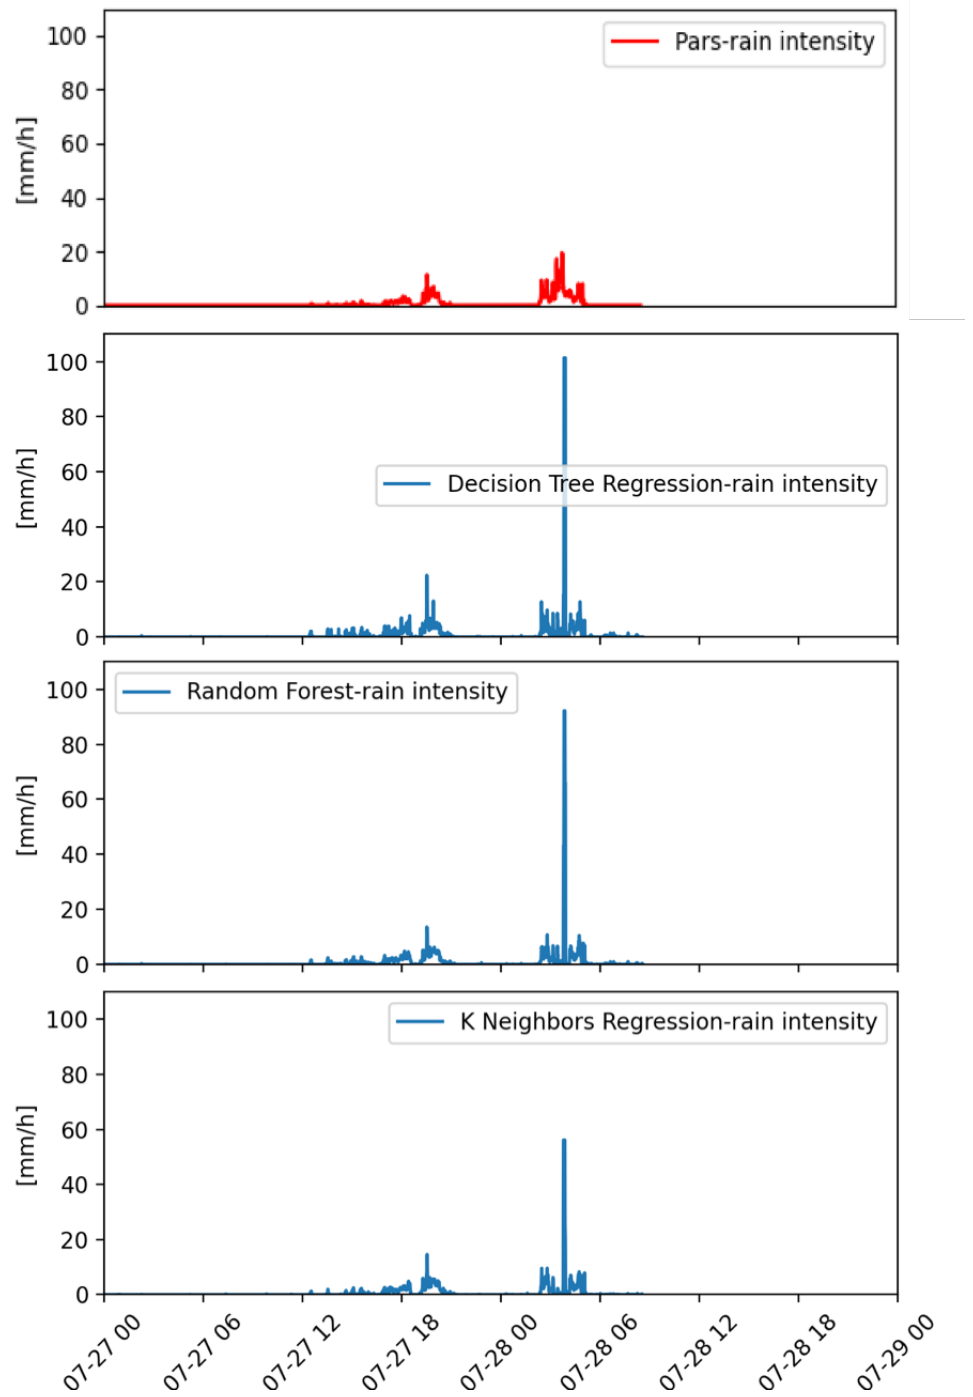
Figure 7. Instantaneous rainfall rate as measured by a co-located reference laser disdrometer (on top) and as estimated by the ML (DTR, RF, KNNR) approaches (from top to bottom, respectively). Data are relative to 27 and 28 July